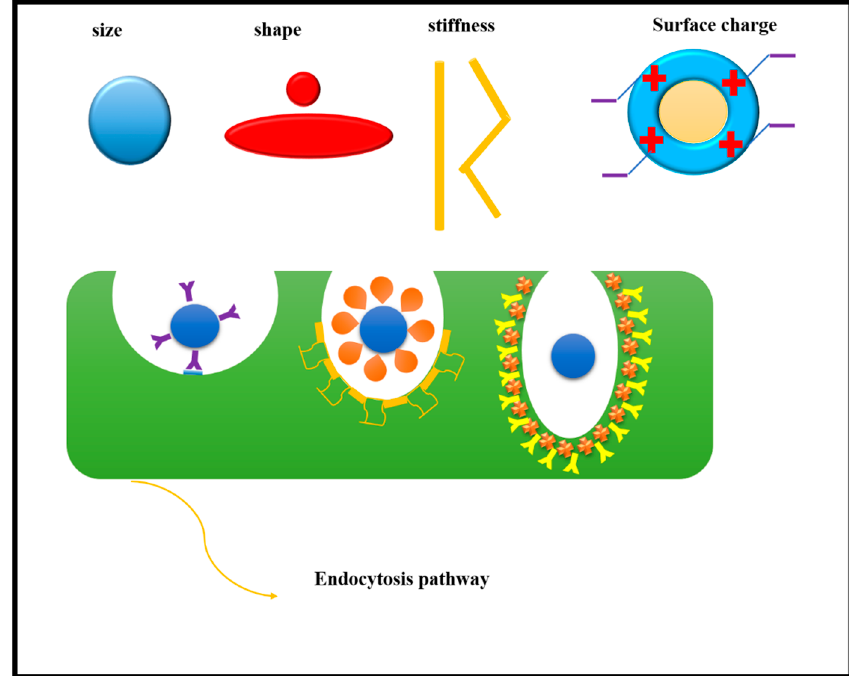
Figure 5. Cellular uptake with endocytosis pathways.